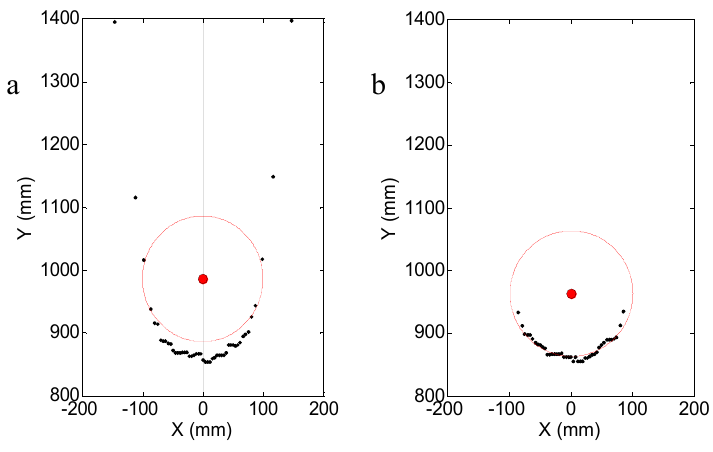
Figure 6. Sample circle fitting with ( a ) and without outliers ( b ).